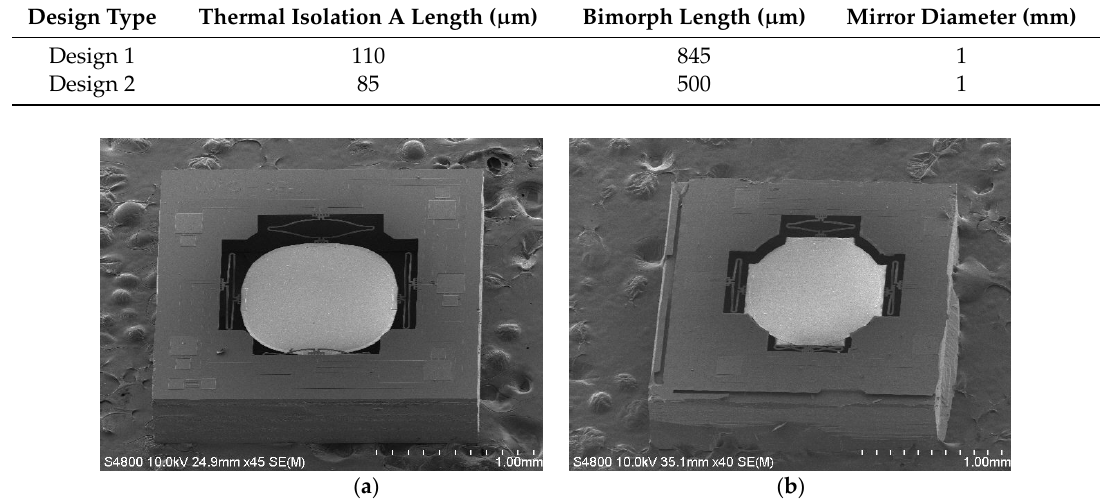
Figure 8. SEMs of two MEMS mirrors. ( a ) Design 1; ( b ) Design 2.